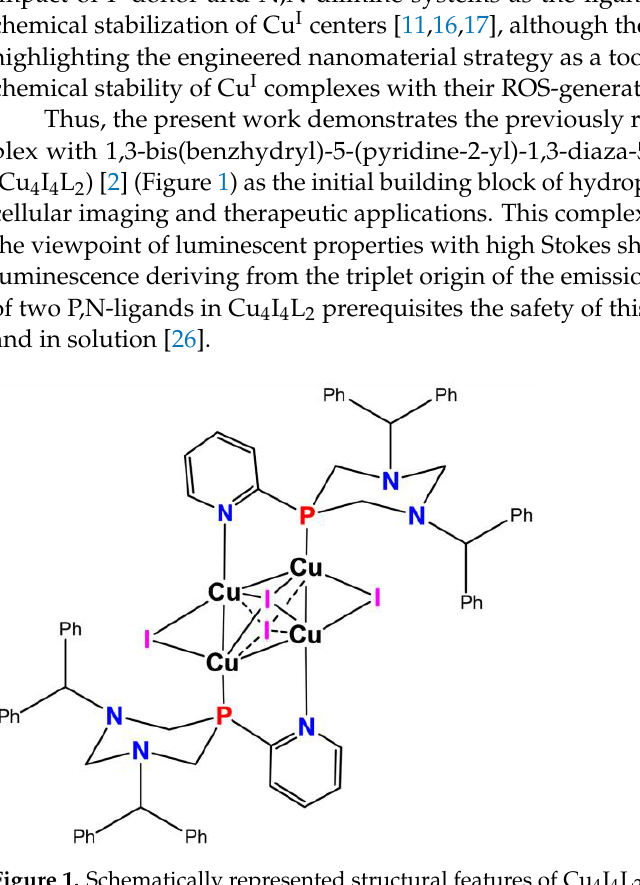
Figure 1. Schematically represented structural features of Cu 4 I 4 L 2 complex.